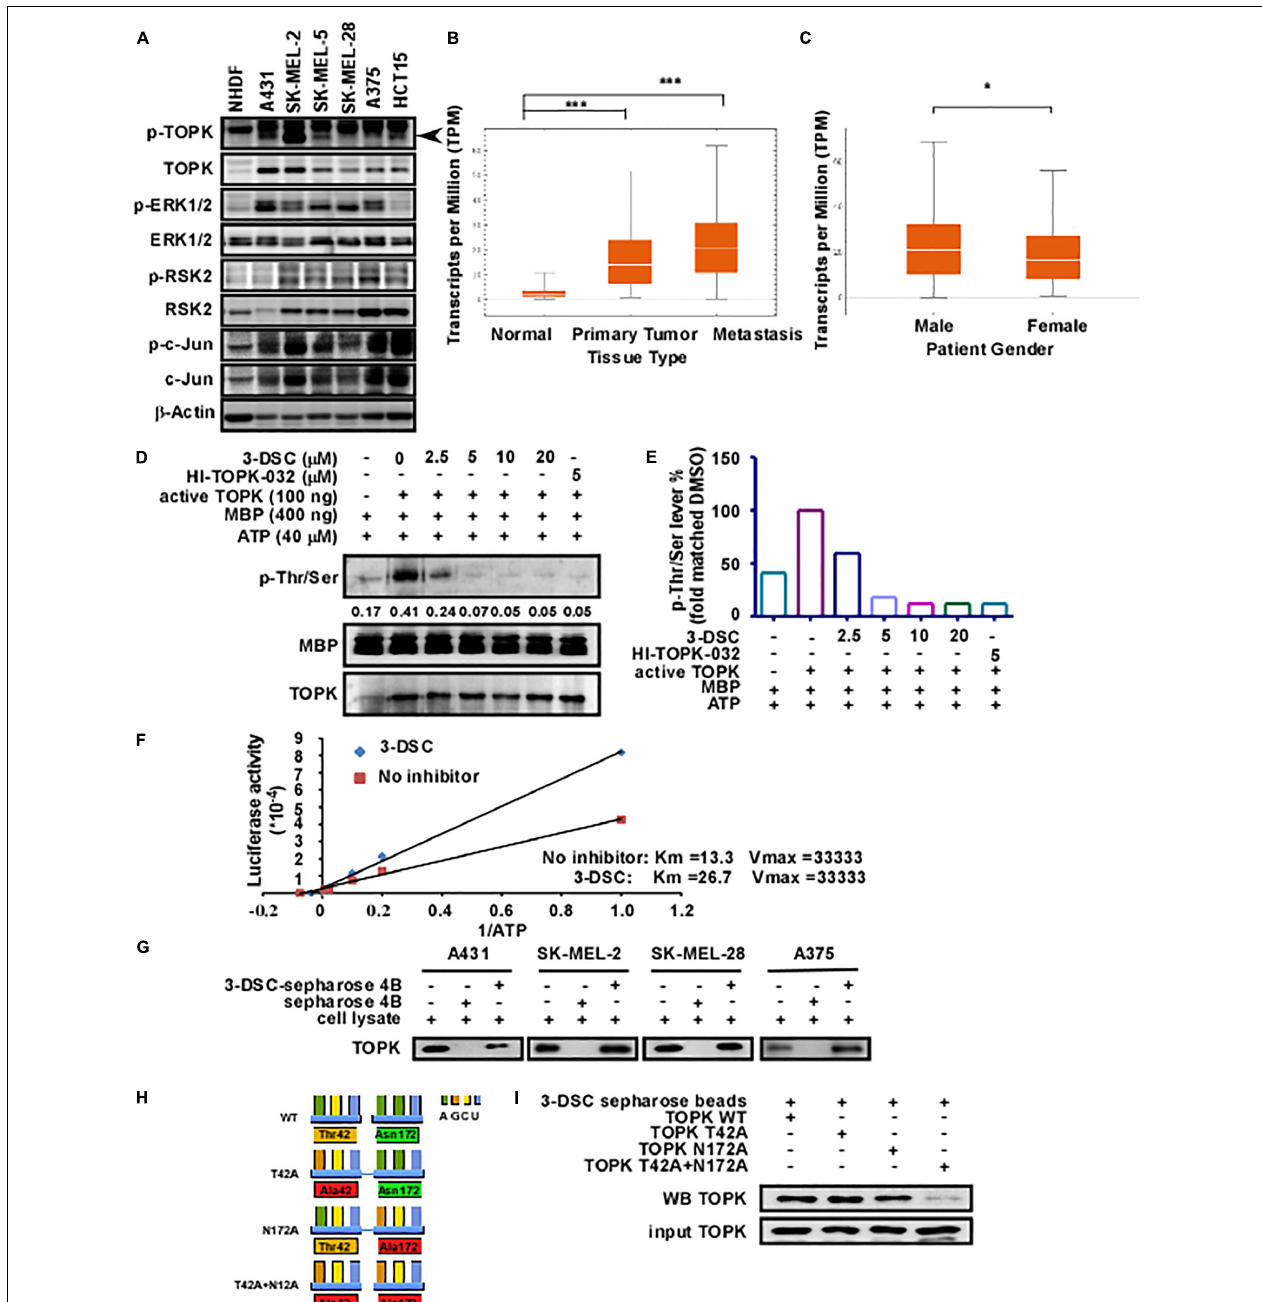
FIGURE 1 | 3-Deoxysappanchalcone (3-DSC) inhibits T-LAK cell-originated protein kinase (TOPK) kinase activity by binding to Thr42 and Asn172. (A) The protein expression levels of TOPK and its downstream protein effectors in Normal Human Dermal Fibroblast (NHDF) and skin cancer cell lines (A431, SK-MEL2, SK-MEL-28, and A375) and colon cancer cell line HCT15 (positive control). (B,C) The expression levels of TOPK dependent on the tumor type (primary melanoma patients, metastatic melanoma patient, and normal person) or gender from The Cancer Genome Atlas-Skin Cutaneous Melanoma (TCGA-SKCM) cohort database. TOPK transcript expression was analyzed according to tissue type according to transcript per million (TPM) units. (D) Effect of 3-DSC on TOPK phosphorylation. Kinase assay was performed with active TOPK (100 ng), 3-DSC (2.5, 5, 10, or 20 µ M), HI-TOPK-032 (5 µ M), myelin basic protein (MBP) (400 ng), and ATP (40 µ M). MBP is the substrate of TOPK kinase; p-Thr/Ser levels are an indicator of TOPK activity. The band intensity of p-Thr/Ser is significantly reduced when the assay was performed with inclusion of 2.5 µ M 3-DSC. (E) Band quantification results of (D) . (F) Kinetic analysis of 3-DSC whether competing ATP with TOPK substrate. Km and Vm values of TOPK enzyme incubated with or without 3-DSC. (G) Binding affinity of 3-DSC to TOPK was assessed in four skin cancer cells. 3-DSC-Sepharose 4B or Sepharose 4B were incubated with cell lysates. Protein was then eluted from the beads and separated by SDS-PAGE. (H) Diagram illustrating the mutation of residues previously predicted to be important in facilitating the interaction between TOPK and 3-DSC. TOPK was mutated at the T42A, N172A, and T42A residues based upon computer docking analysis. (I) In vitro pull-down assay with TOPK WT, TOPK T42A, TOPK N172A, and TOPK T42A + N172A. Double mutation significantly attenuated binding of 3-DSC with TOPK. * p < 0.05, *** p < 0.001.